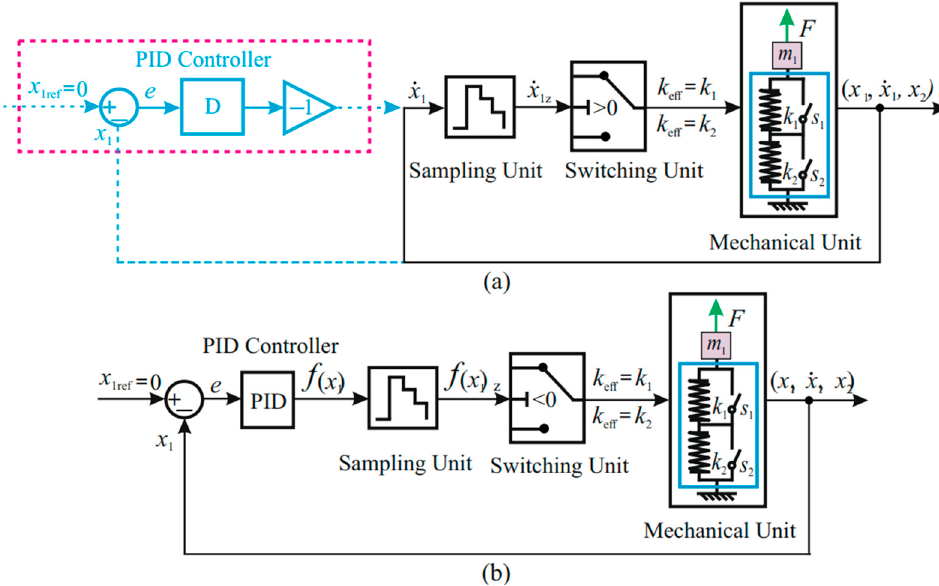
Figure 16. Improved semi-active vibration control switching law: ( a ) old vibration control strategy; ( b ) PID-based vibration control strategy.